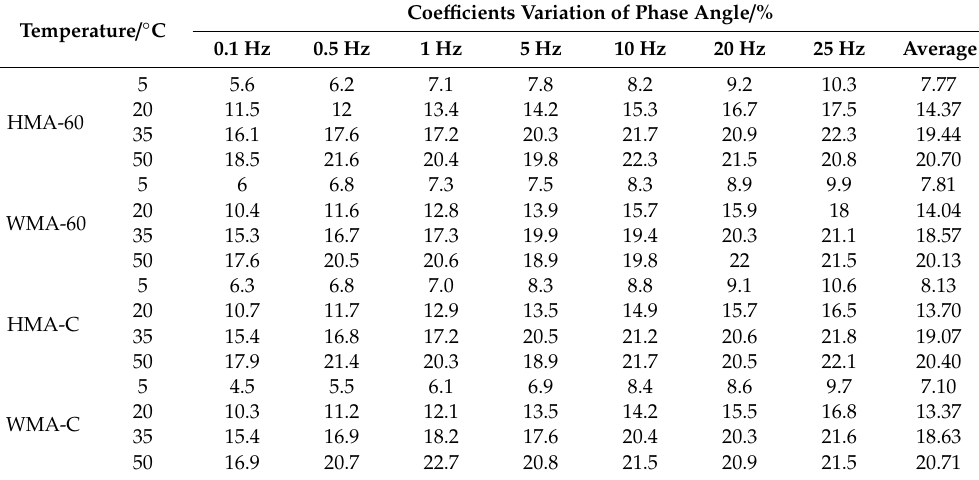
Table A2. Coe ffi cients Variation of Phase